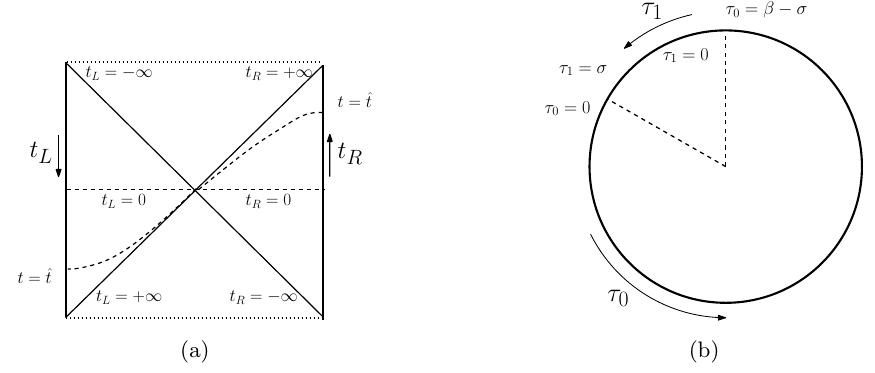
Figure 2 . On the left-hand side (a): an eternal AdS black hole where the arrows indicate the (cid:13)ow of time. We cut along the an initial time slice at t = 0 and a late time slice at t = ^ t (dashed lines), and we keep the region in between them. On the right-hand side (b): a Euclidean black hole in AdS with period (cid:12) . We cut along (cid:12)nite time slices at (cid:28) = 0 and (cid:28) = (cid:12) (cid:27) (dashed lines). For simplicity (cid:0) we have depicted the spacetimes in 2 + 1 dimensions in the global time and radial